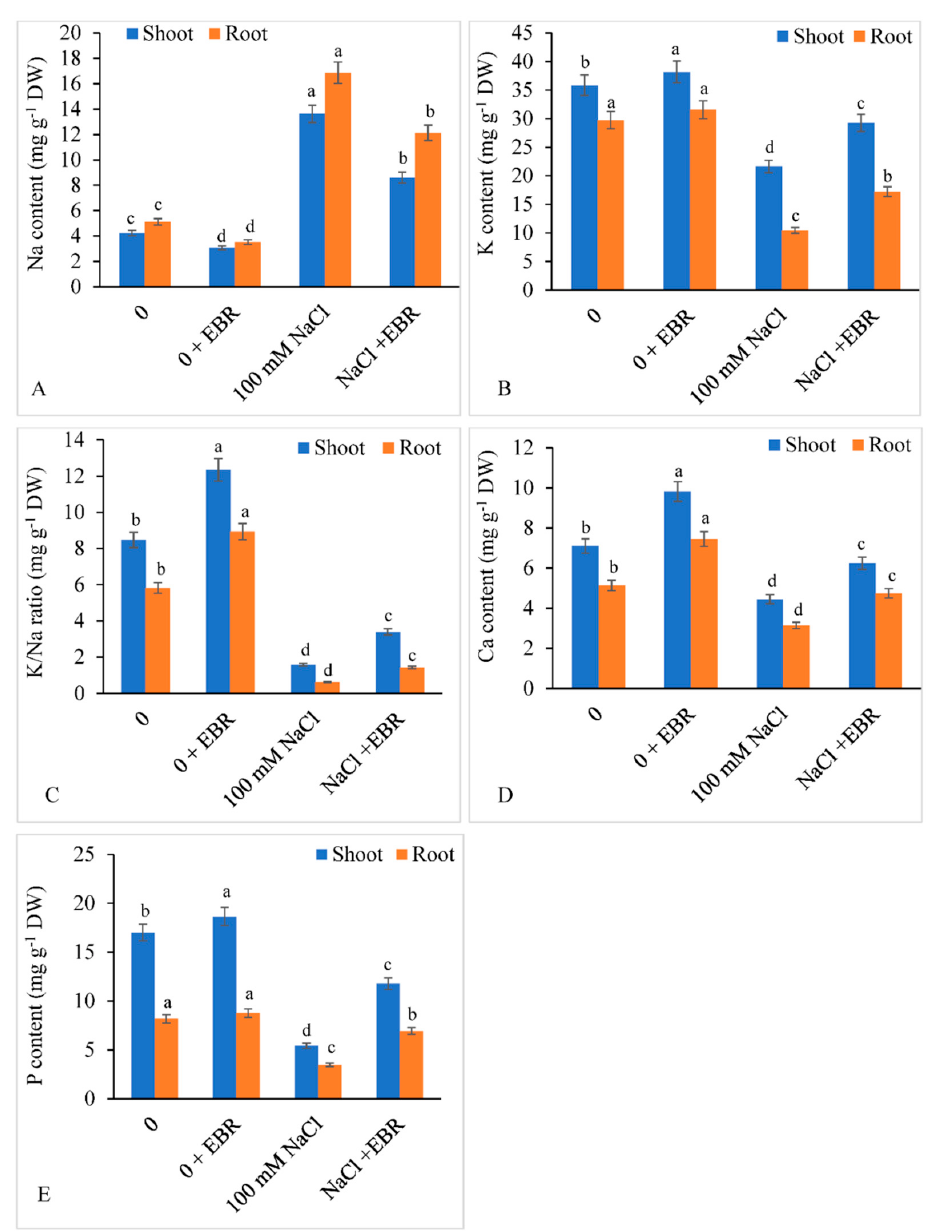
Figure 9. Effect of 24-epibrassinolide (EBR) on shoot and root mineral contents ( A ) Na content, ( B ) K content, ( C ) K/Na ratio, ( D ) Ca content, and ( E ) P content in soybean plants under NaCl stress. Data presented are the means ± SE ( n = 5) and significant difference between the means calculated at p ≤ 0.05 using the Duncan’s multiple range test.